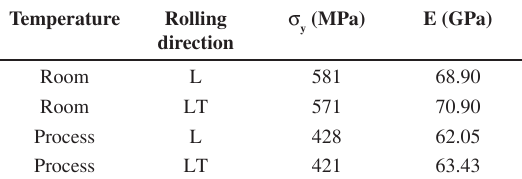
Figure 10. Tensile tests at room and process temperatures. Table 2. Results from tensile